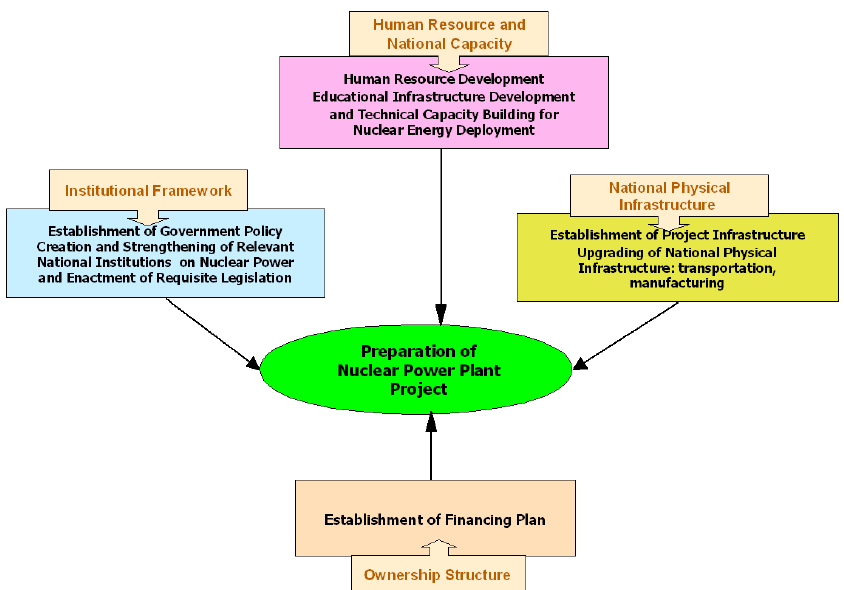
Figure 1. Condensed national nuclear power infrastructure (NPI) development framework [6]